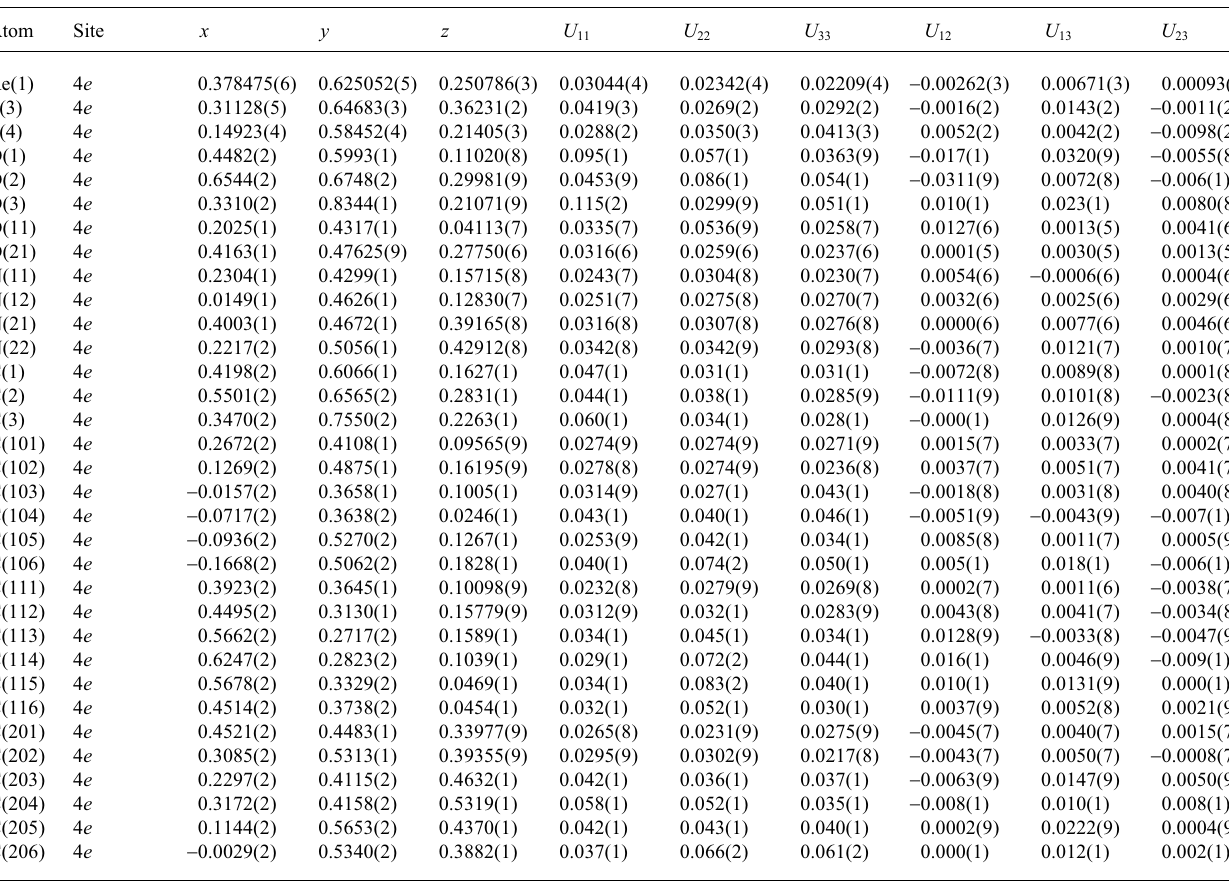
Table 3. Atomic coordinates and displacement parameters (in Å 2 )